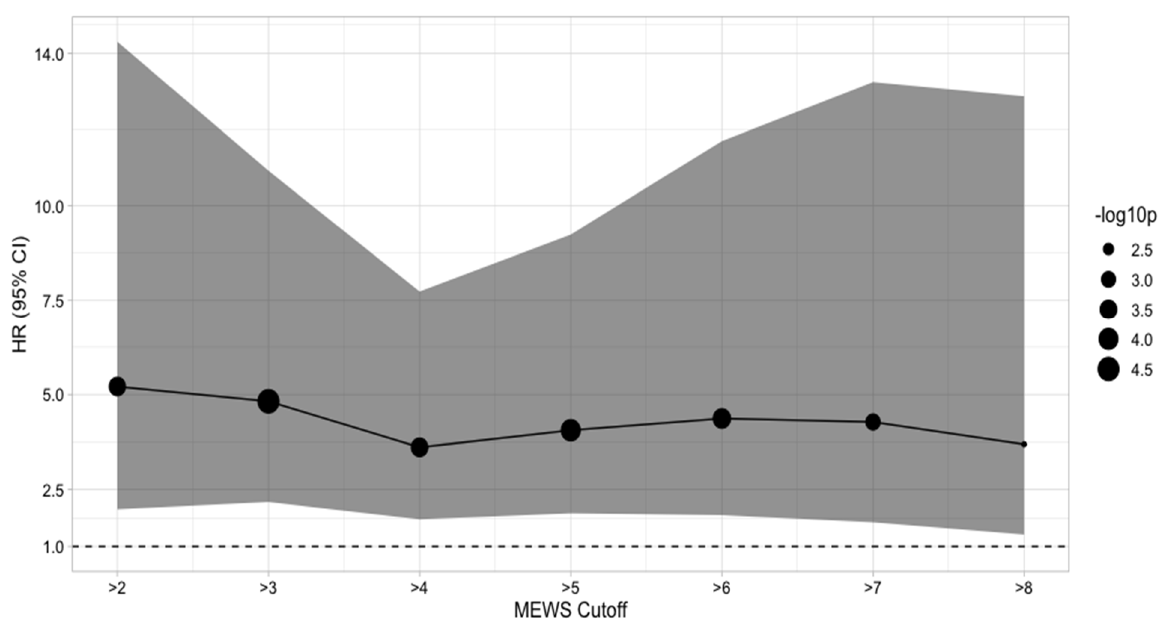
Figure 3. HR of death depending on the selected MEWS cutoff. HR: hazard ratio; CI: Confidence intervals